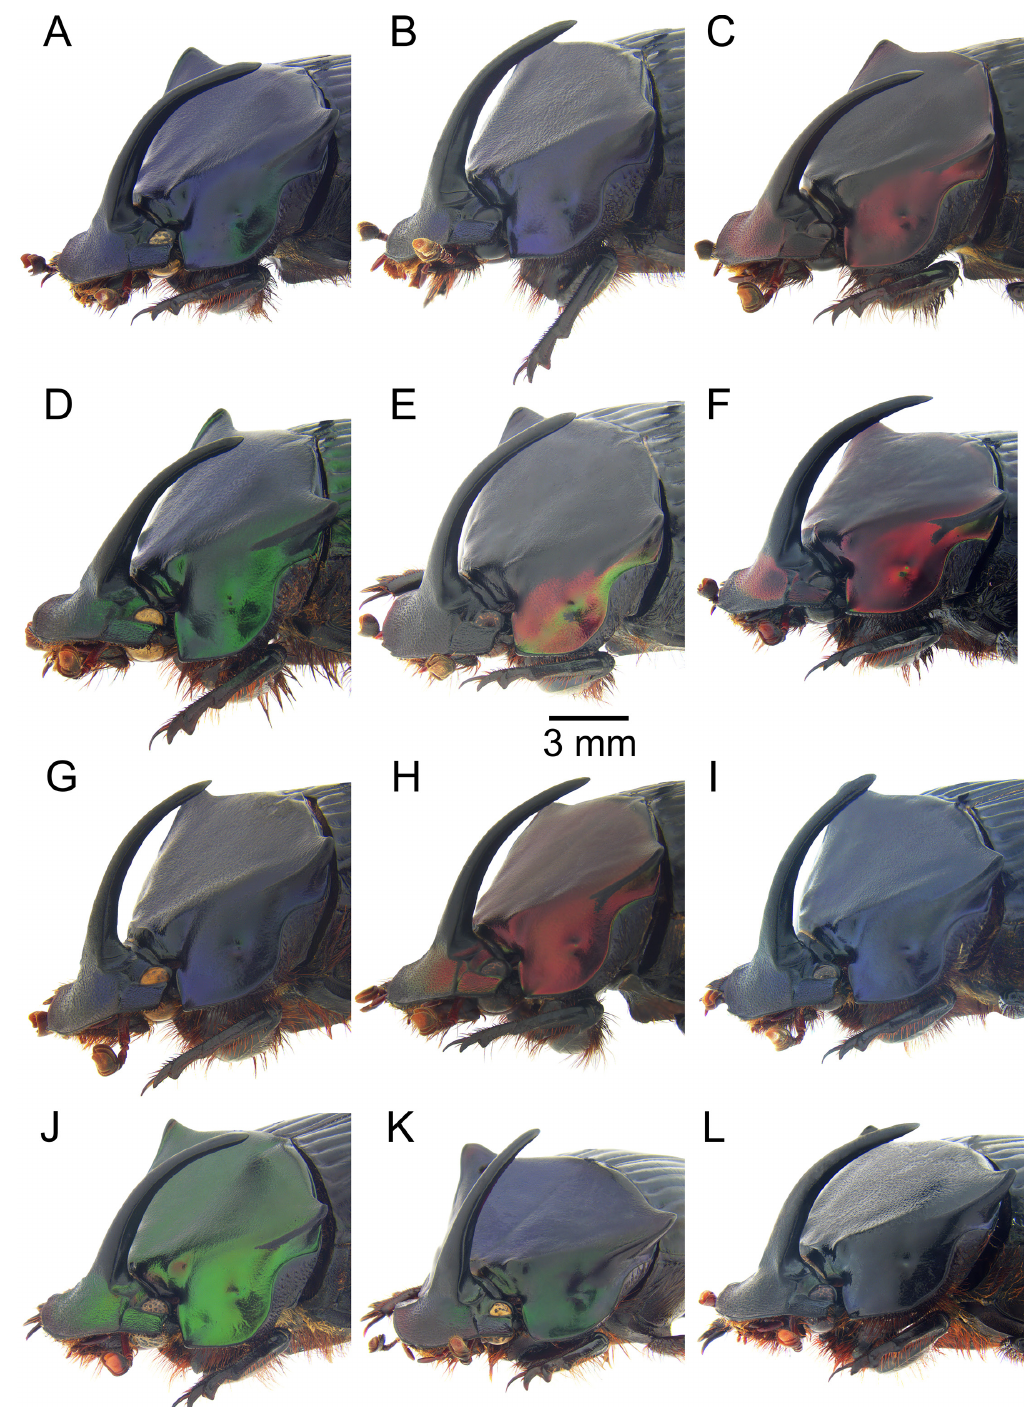
Fig. 2. Lateral view of males within the Phanaeus endymion species group. A . Phanaeus